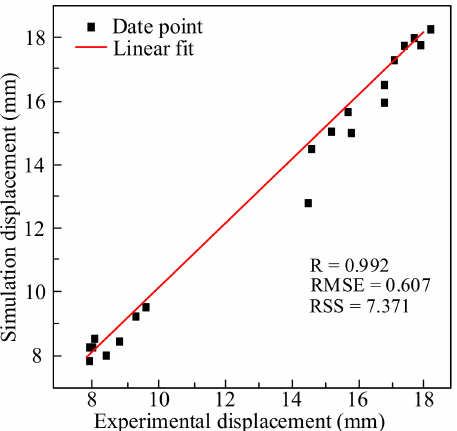
Figure 11. Correlation between simulation and experimental displacement